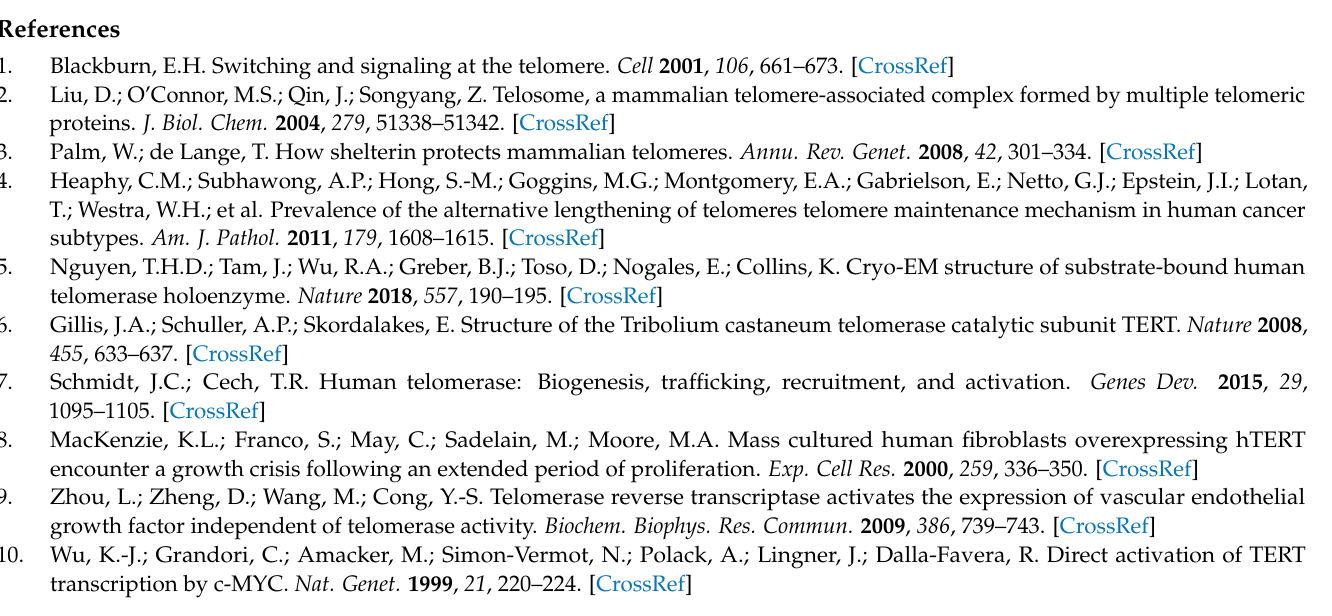
hTERT inhibitors; Figure S2: Effects of Braz treatment on cancer cells; Figure S3: Analysis of HTC75 cell treated with Braz; Figure S4: The mechanism of SC regulates hTERT transcription; Figure